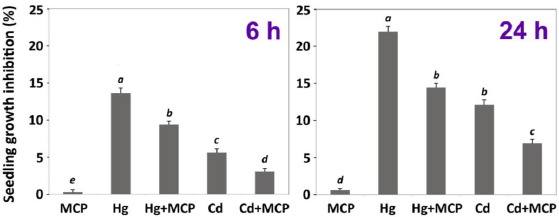
Figure 6. Functional analysis of ethylene-mediated responses to Hg and Cd. Growth inhibition of M. sativa seedlings treated with 3 µM Hg or 30 µM Cd and supplemented with 10 µM 1-MCP, after 6 and 24 h treatment. Significant differences between treatments are shown with different letters ( p < 0 .05, Tukey’s test).